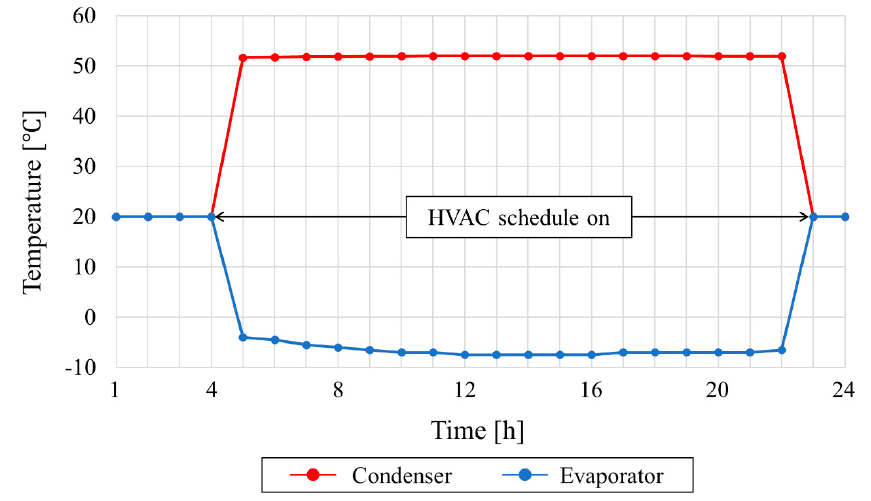
Figure 11. Condenser and evaporator temperatures on a peak day.